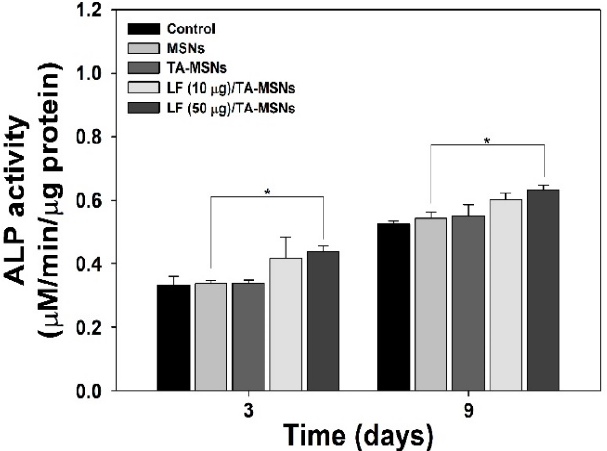
Figure 4. ALP level in ADSCs cultured with MSNs, TA-MSNs, LF (10 μ g)/TA-MSNs, or LF (50 μ g)/TA-MSNs after 3 and 9 days of inoculation ( n = 4 per group). * p < 0.05.